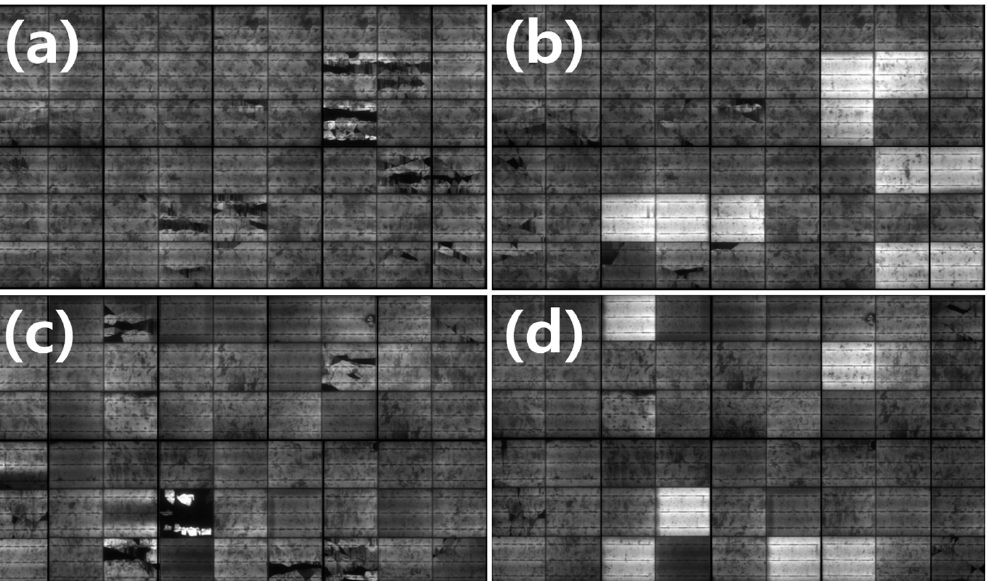
Figure 4. EL images in modules before and after recovery. (190 A, 190 B). ( a ) Among a total of 54 cells from 190 A, 10 cells with a severe crack degree were removed and ( b ) replaced with a new cell to recover. ( c ) Sample 190 B exhibited severe power degradation in approximately six cells, and hot spots due to pore soldering also occurred in the busbar–interconnector connection. ( d ) However, both the power and FF were recovered after cell replacement and pore soldering repair.